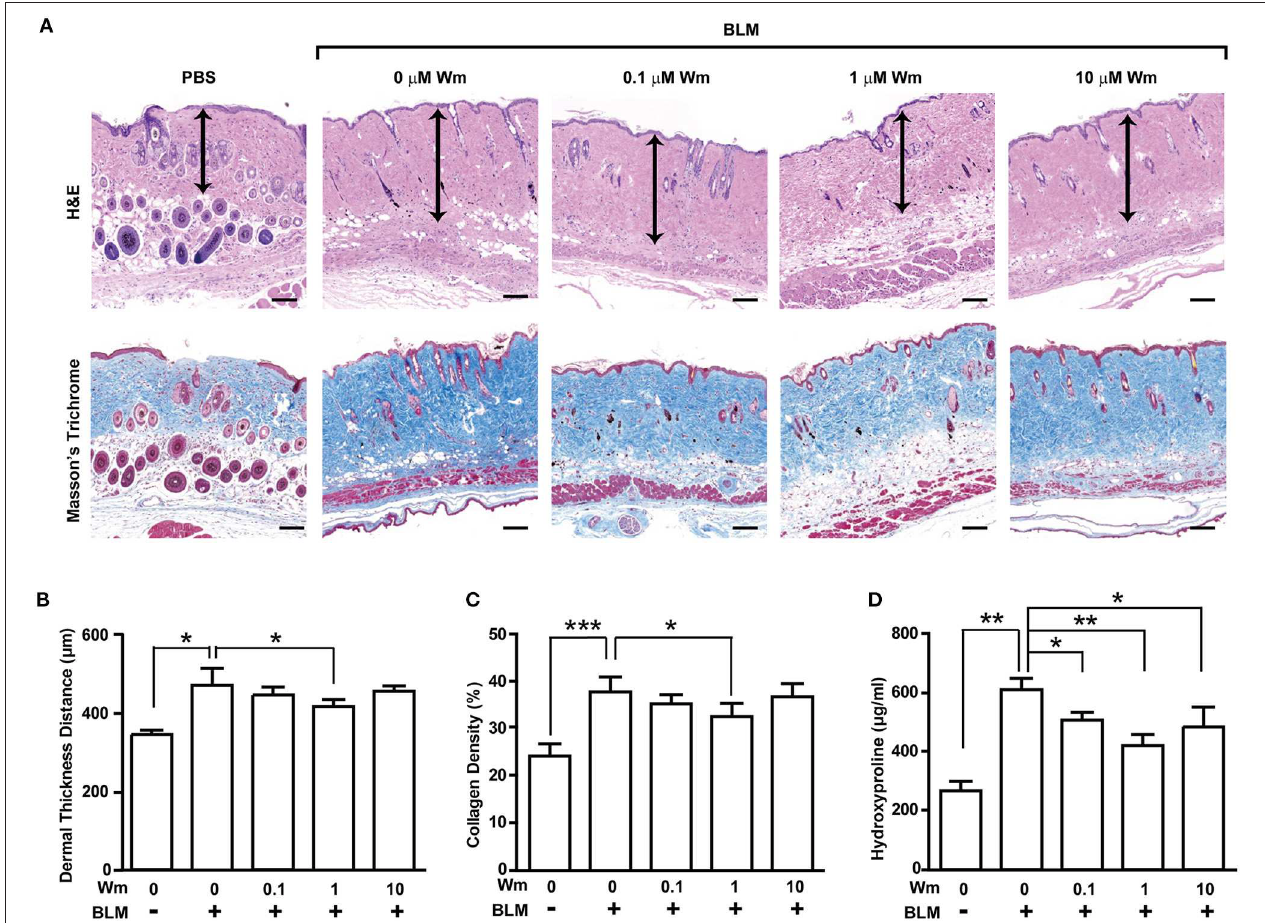
FIGURE 1 | Dose-dependent effects of WKYMVm treatment on tissue fibrosis in a scleroderma mice model. (A) Dose-dependent effect of WKYMVm (Wm) on BLM-induced scleroderma. The BLM-induced scleroderma mice were daily treated with the increasing dose of Wm for additional 3 weeks, and skin sections were stained using H&E and Masson’s Trichrome staining kits. Dermal layer between the epidermal-dermal junction and the dermal-fat junction was indicated with an arrow on H&E-stained sections. Dermal thickness (B) and collagen density (C) were quantified from the H&E and Masson’s Trichrome data, respectively. (D) Effect of Wm on the BLM-induced increase of hydroxyproline content in skin. The levels of hydroxyproline in skin specimens were determined as described in Materials and Methods section. The data are shown as the mean ± SD ( n = 8 per groups). * p < 0.05, ** p < 0.01, *** p <